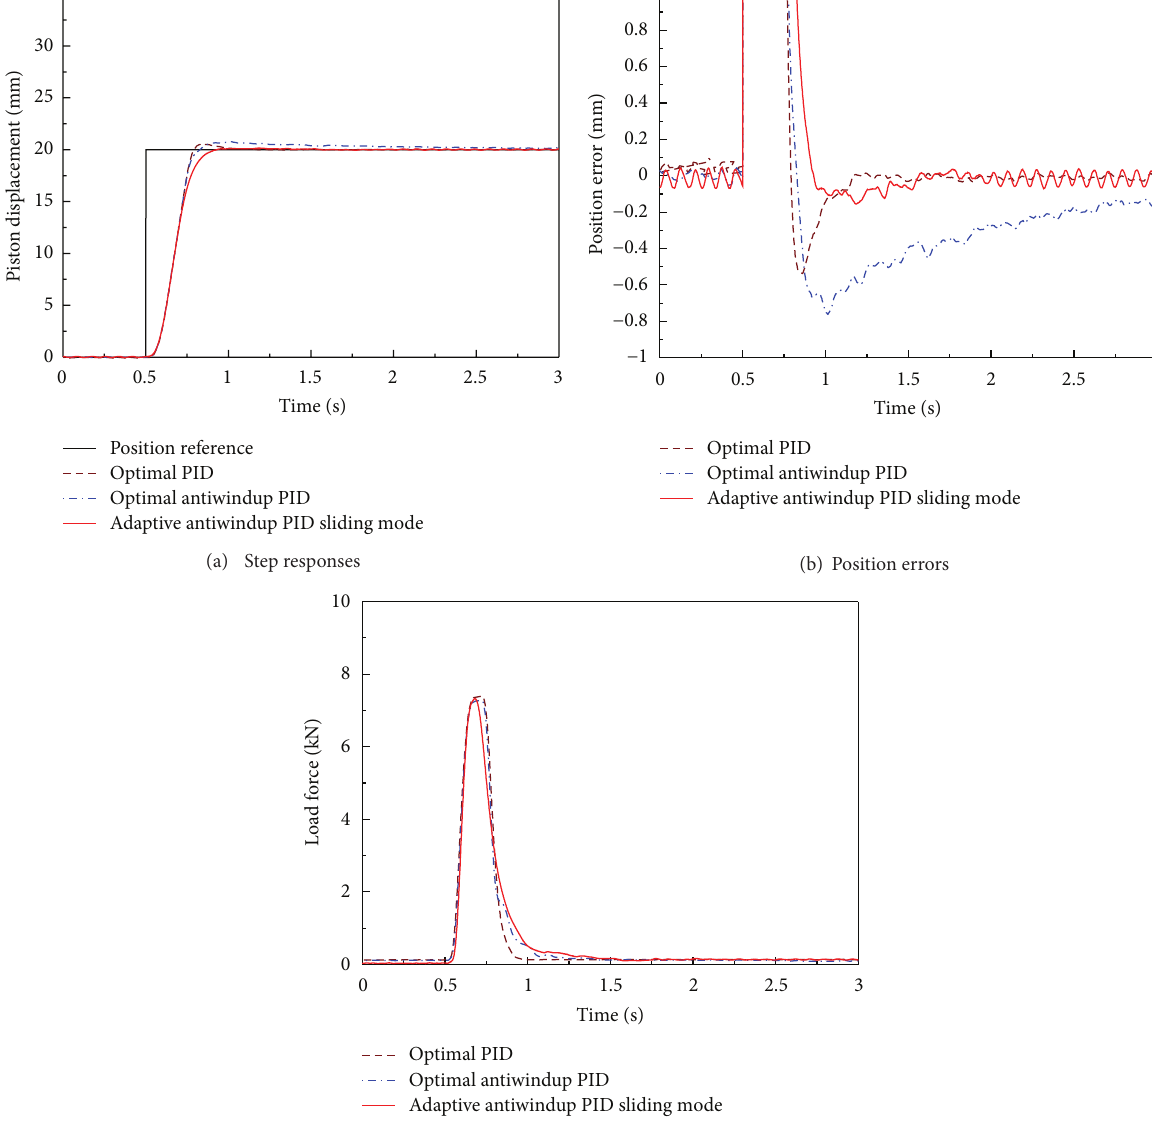
Figure 18: Performances of optimal PID, antiwindup PID, and adaptive antiwindup PID sliding mode control systems for EHA with load disturbance.